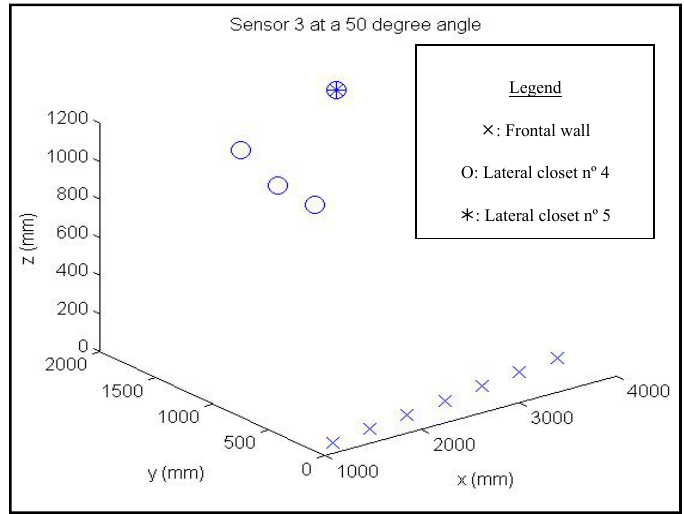
Figure 5. Representation of three-dimensional points corresponding to interactions between a sensor and the